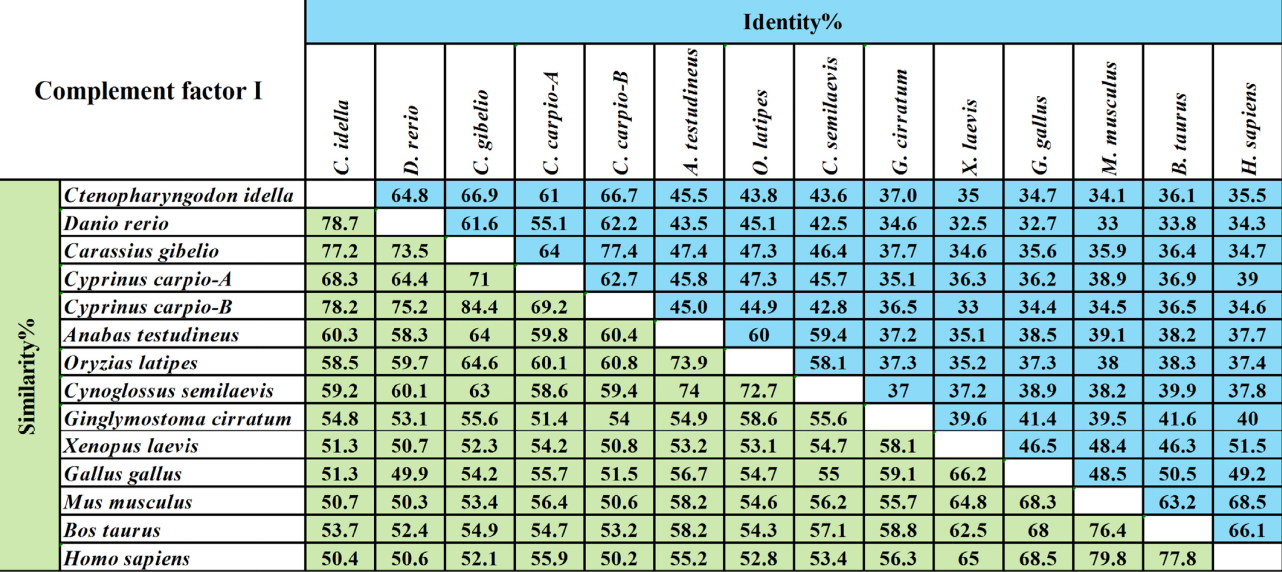
Figure 2. The amino acid sequence identity and similarity for the amino acid sequences of CFI from different species. The values of similarity and identity are backgrounded in green and blue, respec- tively.